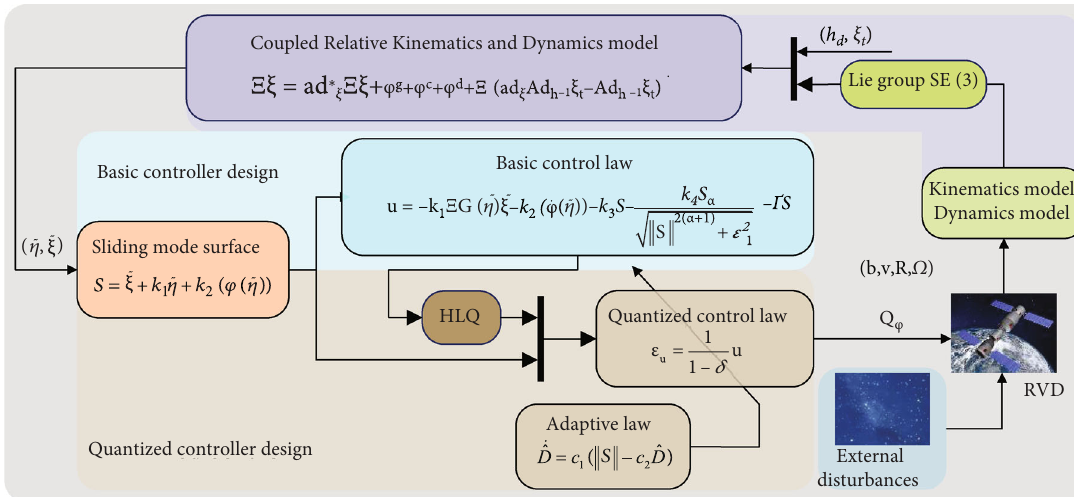
Figure 2: Block diagram of the control architecture for spacecraft rendezvous